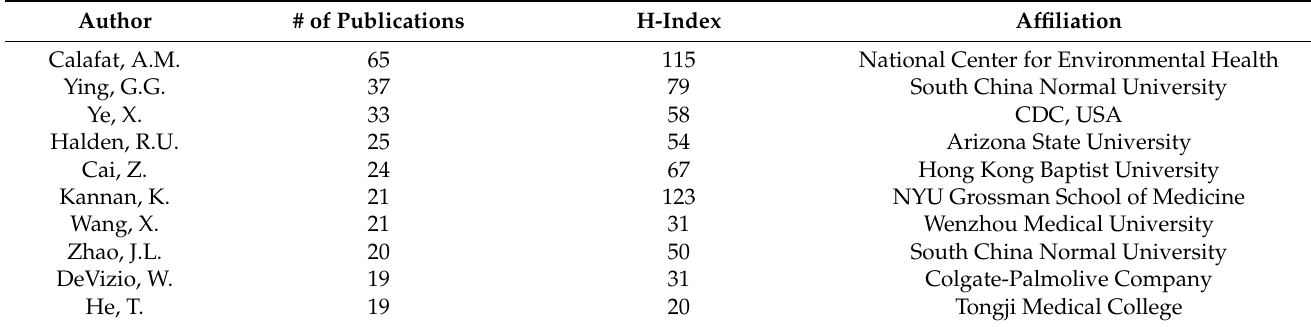
Table 2. Most prominent authors by the number of TCS publications and